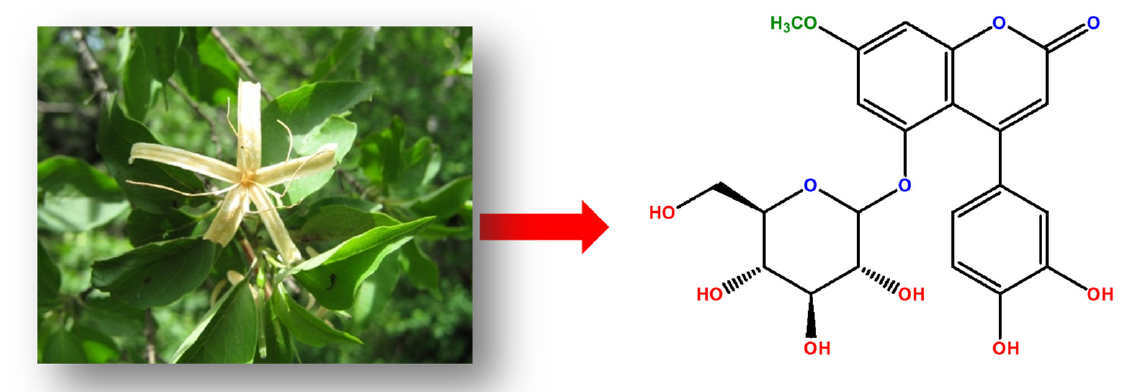
Figure 2. Exostema caribaeum and chemical structure of 4-PC.